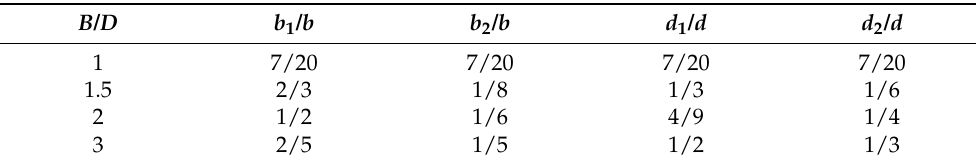
Figure 12. Actual FE stress nephogram and simplified stress distribution of rectangular CFCFST sections: ( a ) FE stress nephogram and ( b ) simplified stress-distribution model. Table 2. Parameters in the simplified stress-distribution model at the middle height of CFCFST columns with different B / D .